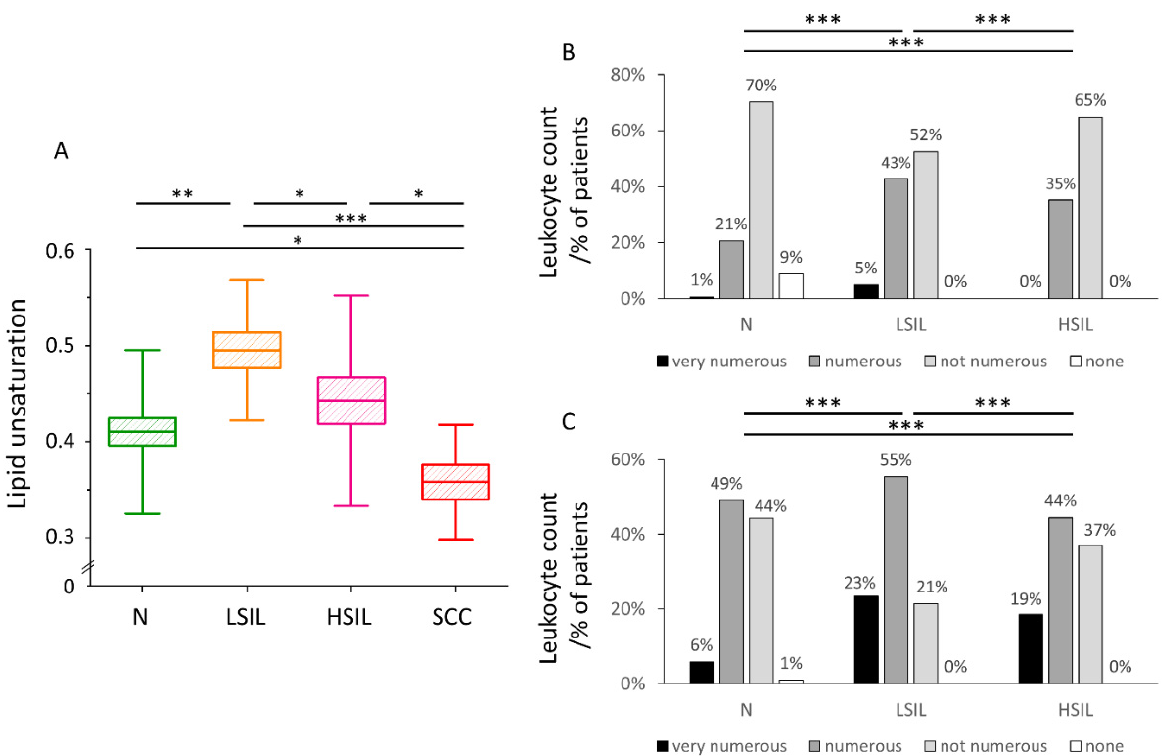
Figure 3. Lipid unsaturation in LDs of cervical epithelial cells correlates with the number of leucocytes in cervical smears . The comparison of the lipid unsaturation level in LDs of cervical epithelial cells in the studied groups obtained by calculating the ratio of the integral intensity of the bands at 1270/1300 cm − 1 ( A ). Mean values ± SEM are given as box plots: mean (horizontal line), SEM (box), minimal and maximal values (whiskers). Percentage of patients grouped based on the number of leukocytes in the cervical Scheme 2017 at The Centre of Microbiological Research and Autovaccines ( B , C ). The comparison of the leukocyte count in the vaginal fornix ( B ) and cervical shield & canal ( C ) in the studied groups: N, LSIL, and HSIL. The leukocytes in each sample were assessed by the cytologist as: very numerous (leukocytes cover about 75% of the field of view), numerous (leukocytes cover about 50% of the field of view), not numerous (leukocytes cover about 25% of the field of view) and none (leukocytes cover 0% of the field of view). * p < 0.05, ** p < 0.01, *** p < 0.001.